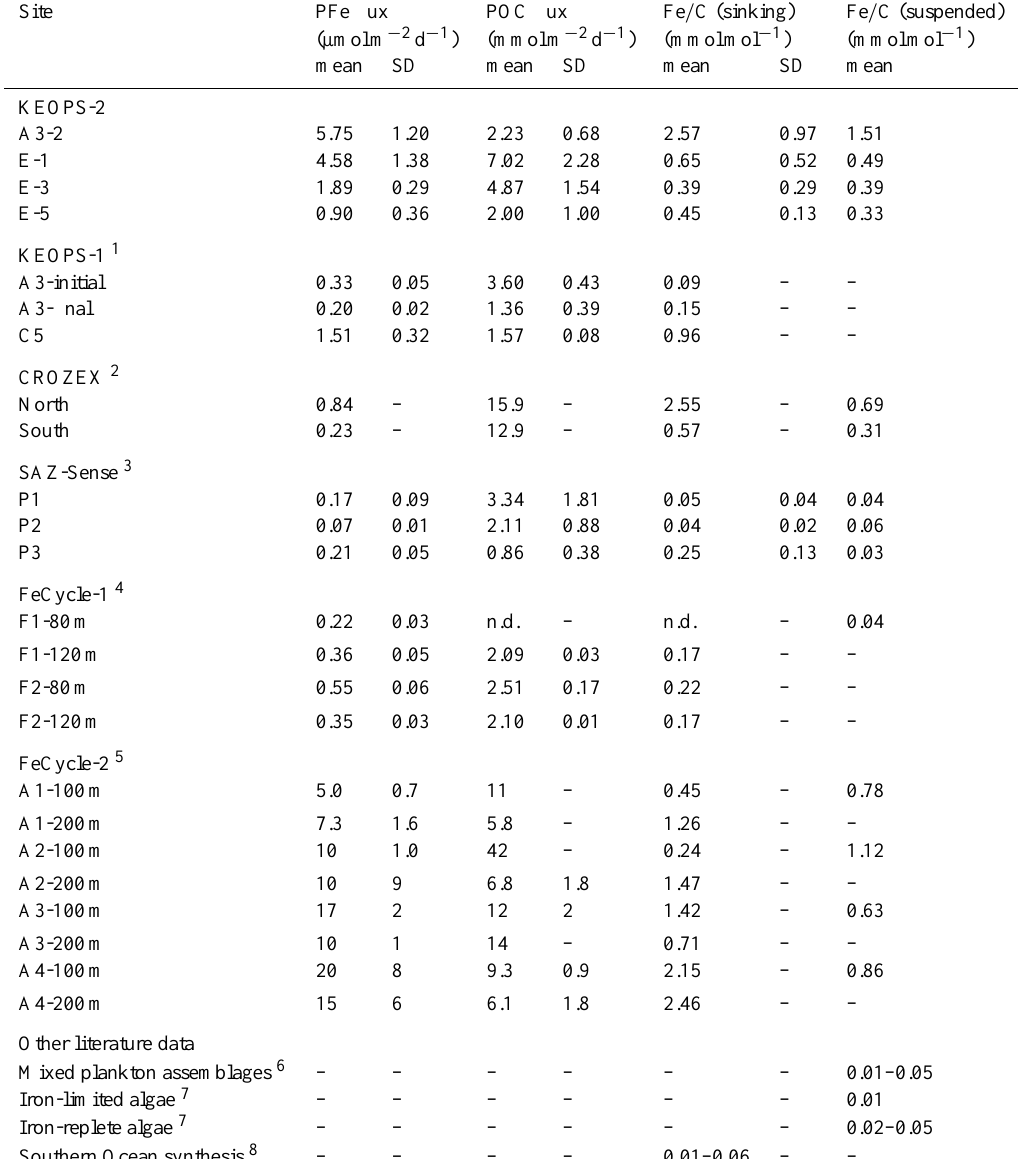
Table 2. Fluxes of iron and carbon (mean and standard deviation, SD) exported in sinking particles (trap deployed at 200m) and ratio of Fe / C in sinking (traps) and suspended mixed layer (ISP) particles at stations A3-2 and E-stations. There was no successful trap deployment at station R-2. A comparison to previous studies is